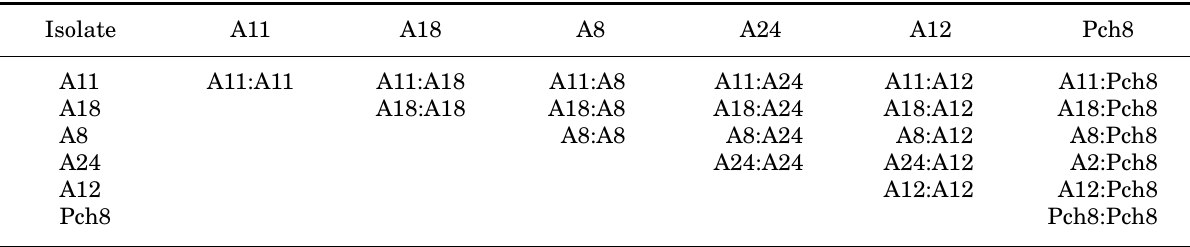
Table 3. Pairings of isolates tested for mycelial compatibility.